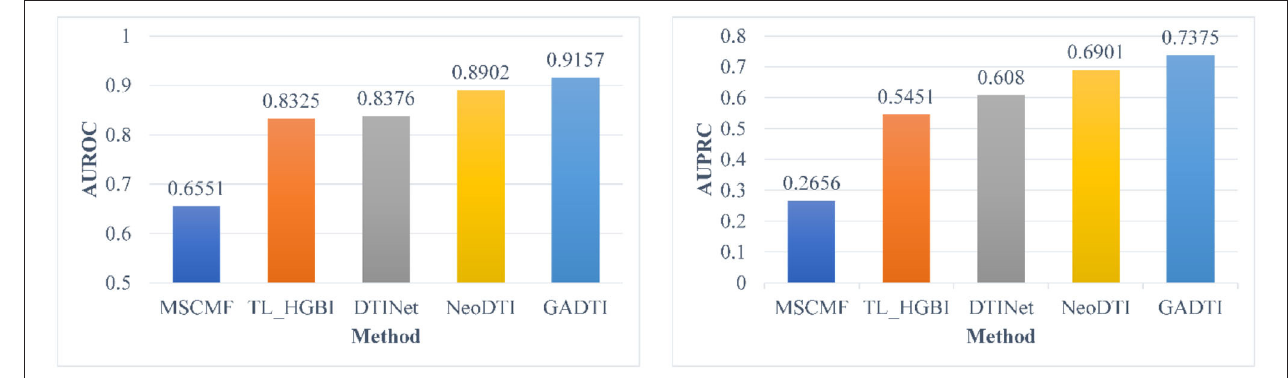
FIGURE 7 | Comparison between different methods in terms of AUROC and AUPRC based on 10-fold cross-validation (#positive: #negative = 1:10, DTIs with similar drugs or targets were removed).